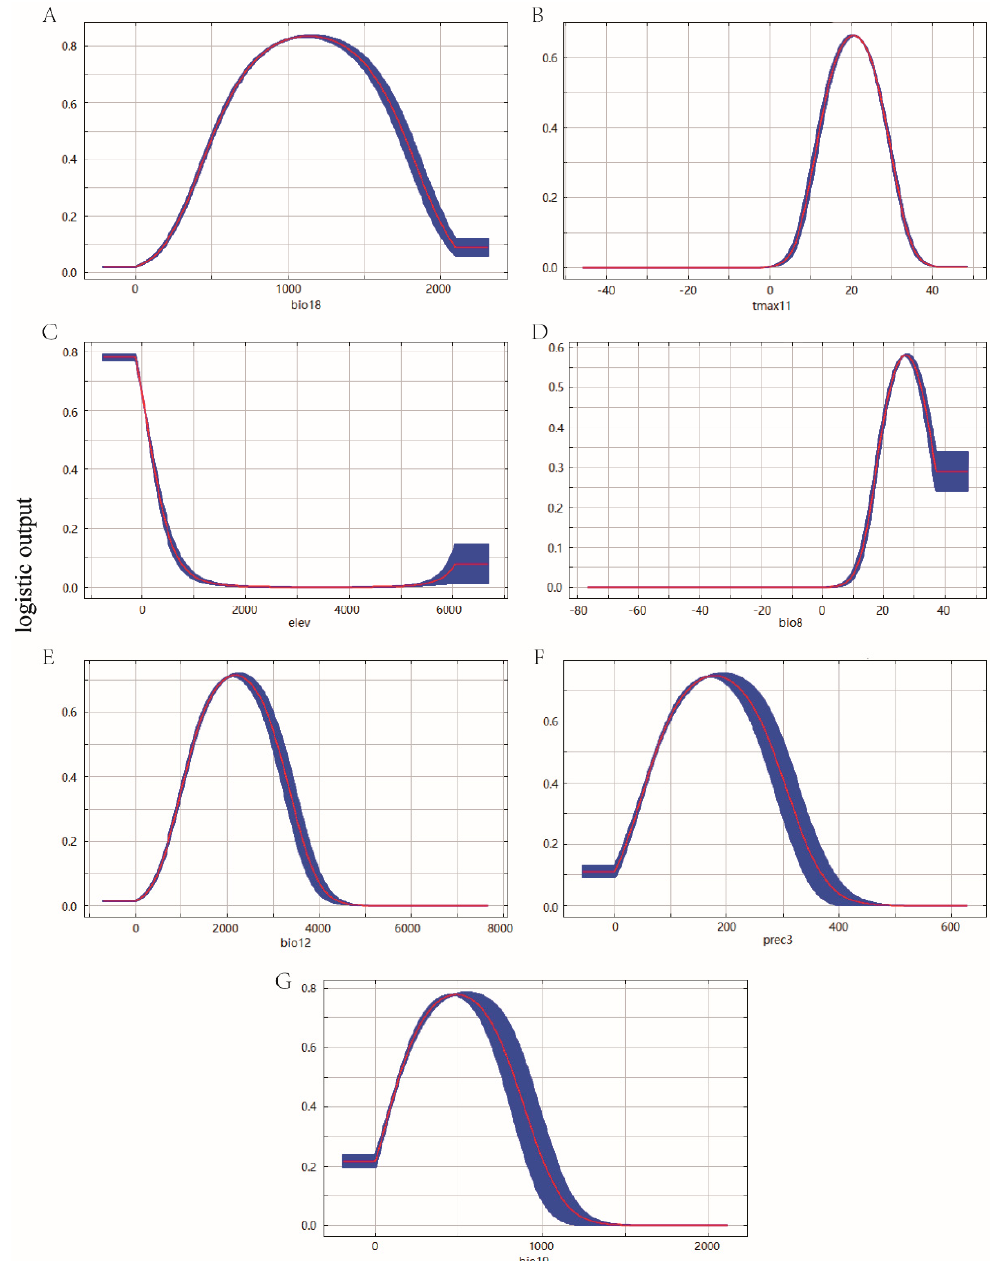
Figure 5. Response curves of environmental variables in the potential distribution model of P. canaliculata . The red curves represent average value over 10 replicate runs, while blue margins represented ± SD calculated for 10 replicates: ( A ) Bio18, ( B ) Tmax11, ( C ) Elev, ( D ) Bio8, ( E ) Bio12, ( F ) Prec3, and ( G ) Bio19.